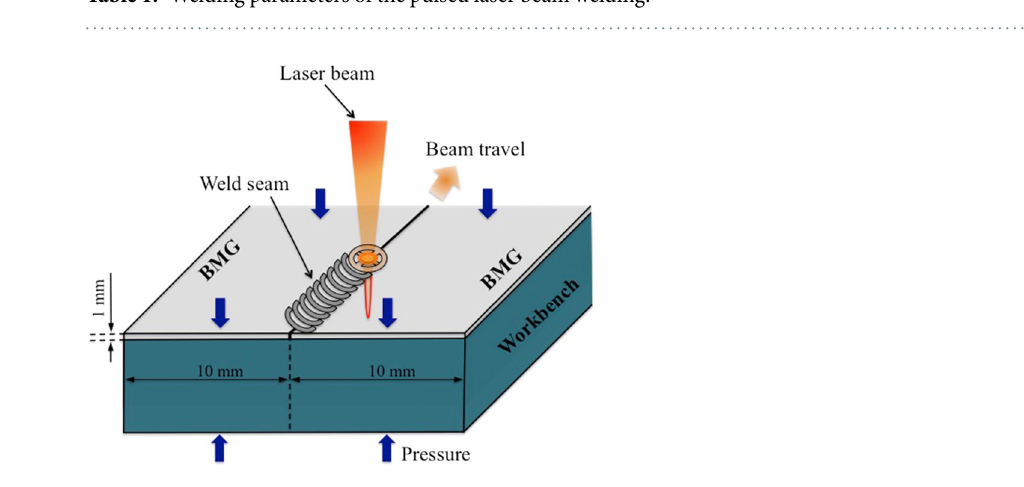
Table 1. Welding parameters of the pulsed laser beam welding.